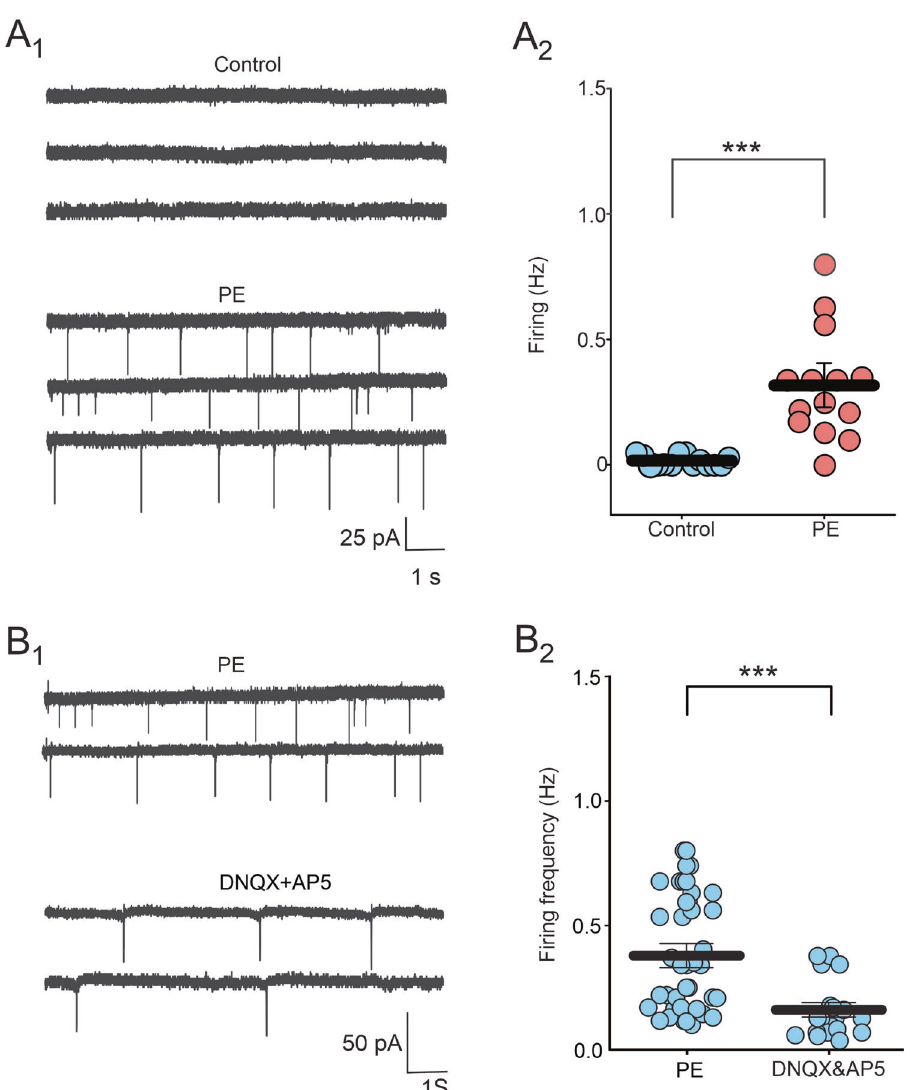
Fig. 2 Prenatal ethanol exposure increases the spontaneous fi ring activity of DRn 5-HT neurons by increasing glutamatergic synaptic transmission. A PE increases the fi ring activity of DRn 5-HT neurons. A 1 Cell-attached recordings of DRn 5-HT neurons from control (upper panel) and PE rats (lower panel). A 2 Summary of the average fi ring frequency of DRn 5-HT neurons recorded from control ( , n = 14, N = 5 from 3 litters) and PE rats ( , n = 14, N = 5 from 3 litters, Mann-Whitney test: p < 0.001). B Blockade of ionotropic glutamate receptors signi fi cantly reverses the PE-induced increase in spontaneous fi ring activity of DRn 5-HT neurons. B 1 Recordings of spontaneous fi ring activity of DRn 5-HT neurons from PE rats in the absence (upper traces) and presence (lower traces) of AMPA and NMDA receptor antagonists, DNQX (20 µM) and AP5 (20 µM), respectively. B 2 Summary graph of the spontaneous fi ring frequency of DRn 5-HT neurons recorded in PE rats in the absence ( n = 38, N = 10 from 5 litters) and presence of DNQX and AP5 ( n = 20, N = 7 from 3 litters, Mann-Whitney test: p < 0.01). n = number of cells, N = number of reduced the amplitude of eEPSCs in PE, but not control rats long-term potentiation and depression of glutamate synapses in (Control: 102.36 ± 7.67% of baseline; PE: 70.85 ± 5.92 % of baseline; the DRn, respectively [37 – 39]. Because PE alters the function of p < 0.05, ɳ 2 = 0.42, PE vs PC; Fig. 4A neuronal nitric oxide synthase (nNOS) function [40] and enhances 2 ). These observations suggest P the formation of reactive nitrogen species (RNS), including peroxynitrite (ONOO - ) [41, 42], we hypothesized that an enhanced NO signaling could mediate the PE-induced potentiation of DRn glutamate synapses. We fi rst tested this hypothesis by examining whether reducing tonic NO signaling using NOS inhibitors and NO scavengers can reverse the potentiation of glutamate synapses in PE rats. Remarkably, inhibition of NOS with L-NAME (100 µM) Fig. 4C 1 -C 2 ). Collectively, these results indicate that an enhanced signi fi cantly reduced the amplitude of eEPSCs only in DRn slices of tonic NO signaling mediates the PE-induced potentiation of DRn PE rats (Control: 108.2 ± 1.98 % of baseline; PE: 58.21 ± 5.5 % of glutamate synapses. baseline; p < 0.05, ɳ 2 P = 0.73, PE vs PC; Fig. 4A 1 ). Similarly, bath In principle, if the PE-induced potentiation of DRn glutamate synapses were to be mediated by an enhanced tonic NO application of the NO scavenger PTIO (100 µM) signi fi cantly